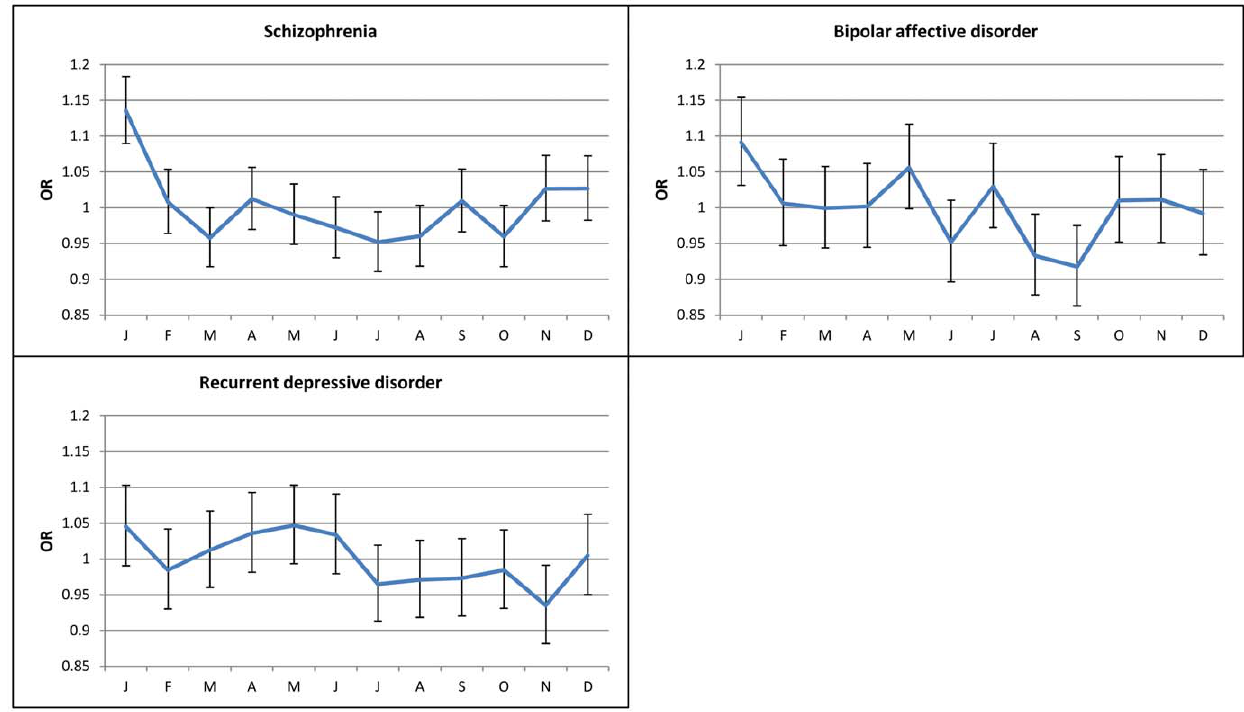
Figure 1. Monthly OR based on month of birth in SC, BAD and RDD.